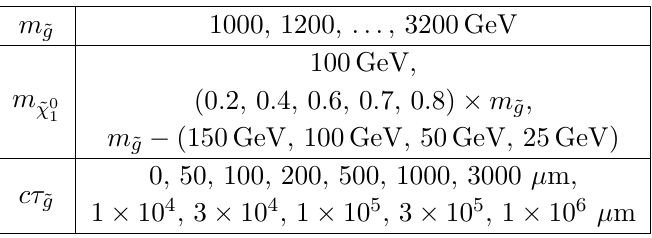
Table 1. Sample points for signal events. We generate 50000 events for each sample